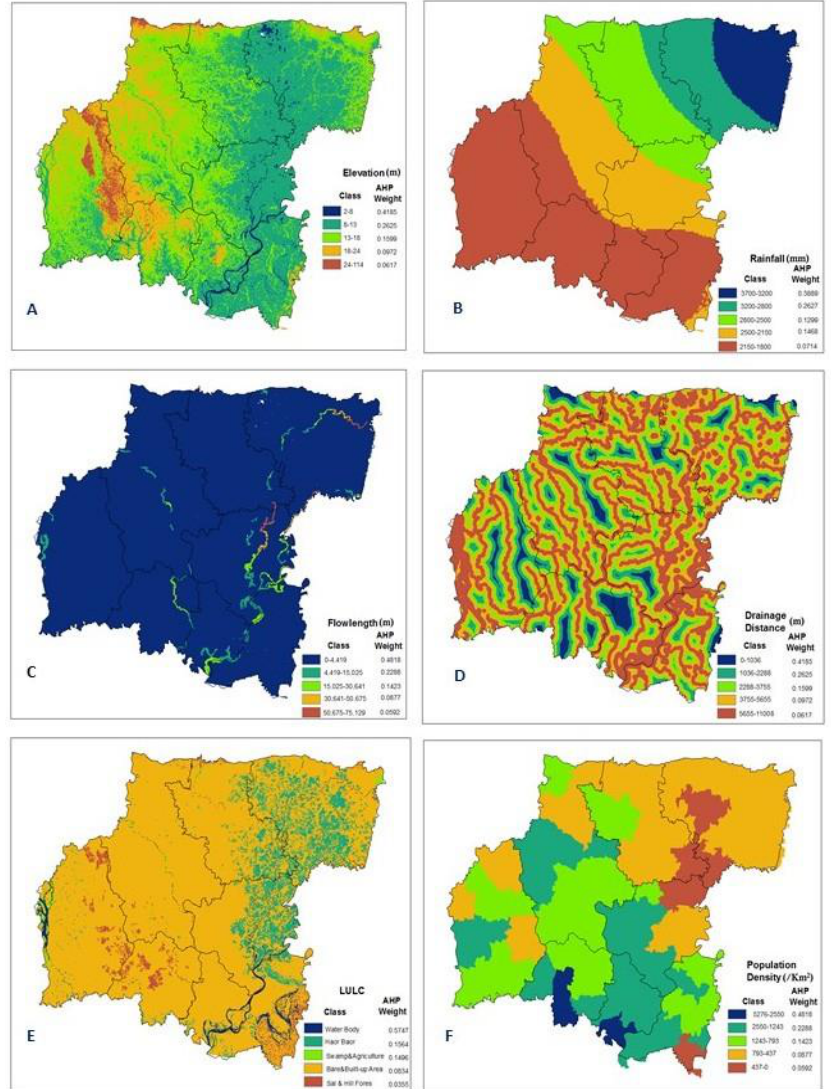
Figure 3: Reclassified maps: ( A ) Elevation (m); ( B ) Precipitation (mm); ( C ) Flowlength (m); ( D ) Drainage distance (m); ( E ) Land-use/Land-cover (LULC); ( F ) Population density (/km 2